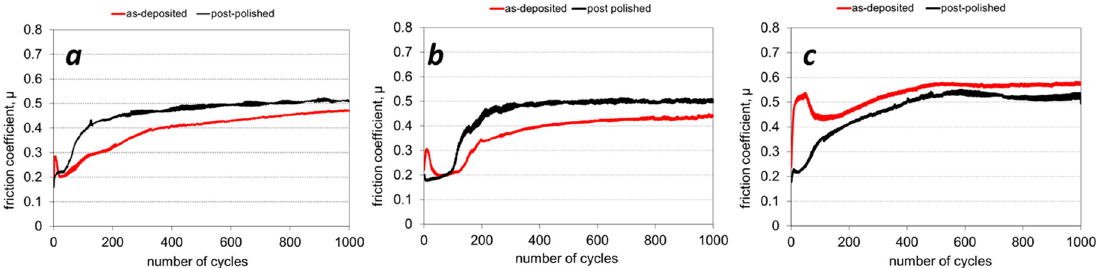
Figure 7. Friction curves of as-deposited and polished BAI ( a ), CC7 ( b ) and AIP ( c ) samples (TiN/D2).